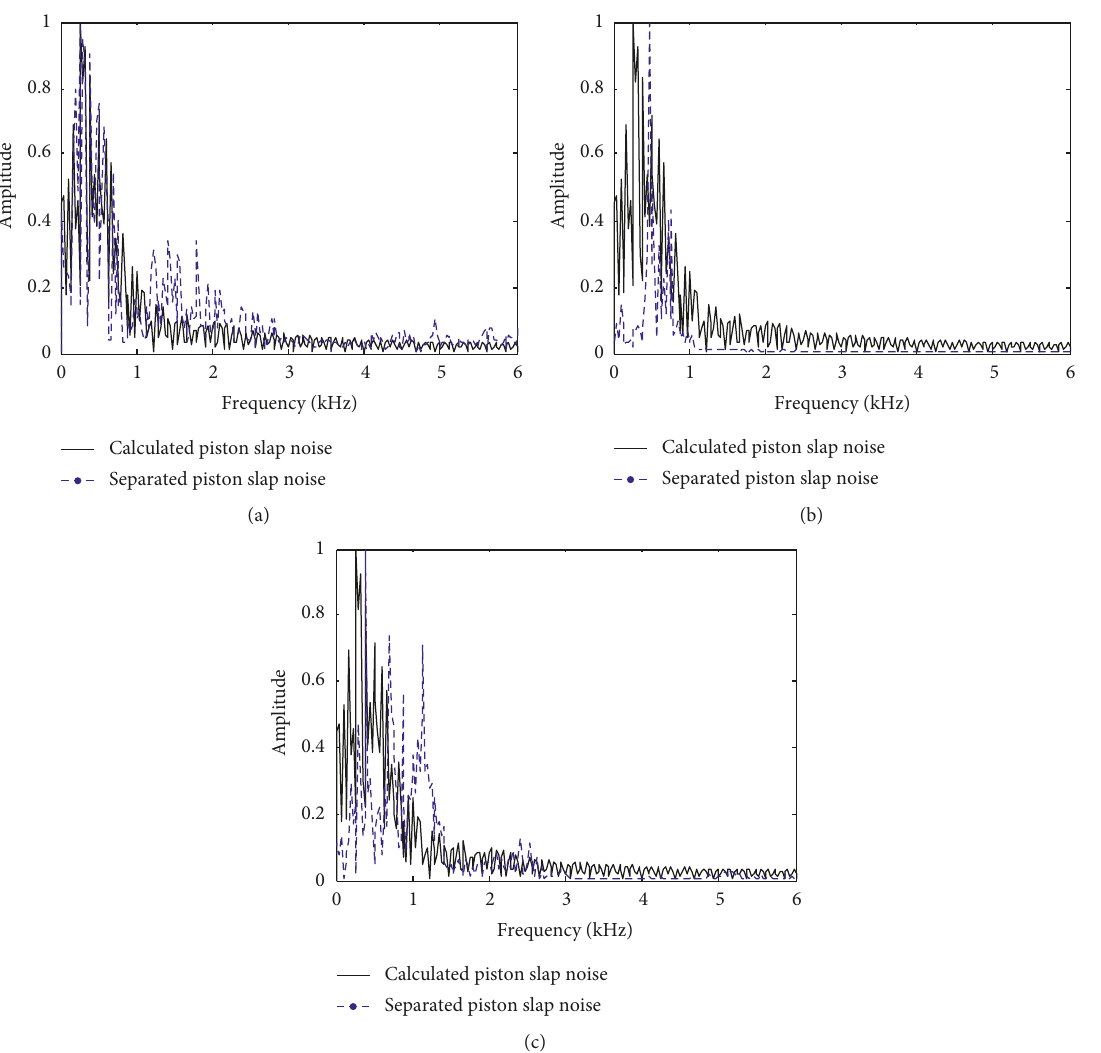
Figure 22: The compared results between calculated piston slap noise and separated piston slap noise. At (a) cylinder head top, (b) main slap side, and (c) vice slap